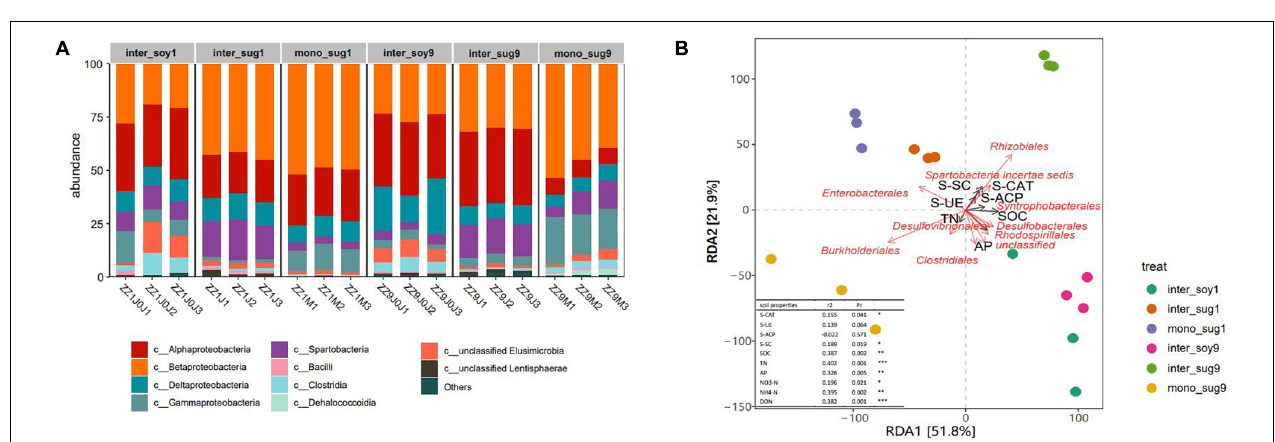
FIGURE 3 | (A) Relative abundance of different phyla in each pattern. (B) Distance-based redundancy analysis of different patterns (dot) and environmental factors (arrows) indicates the dominant communities and influential environmental factors, Pr ≤ 0.001(***), Pr ≤ 0.01(**), * Pr ≤ 0.05(*).